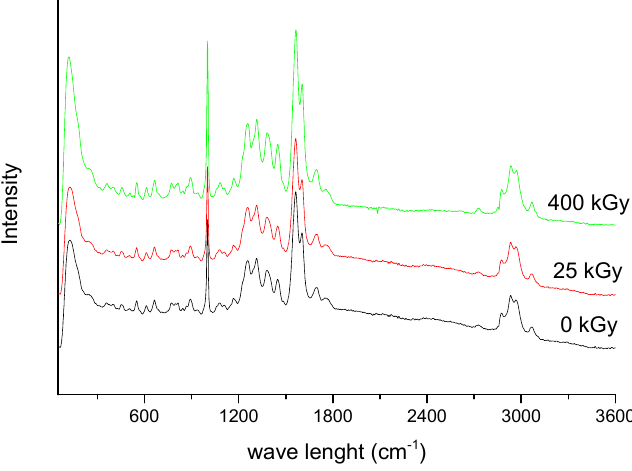
Figure 7. Fourier Transform Infrared (FT-IR) spectra of non-irradiated and irradiated ertapenem.